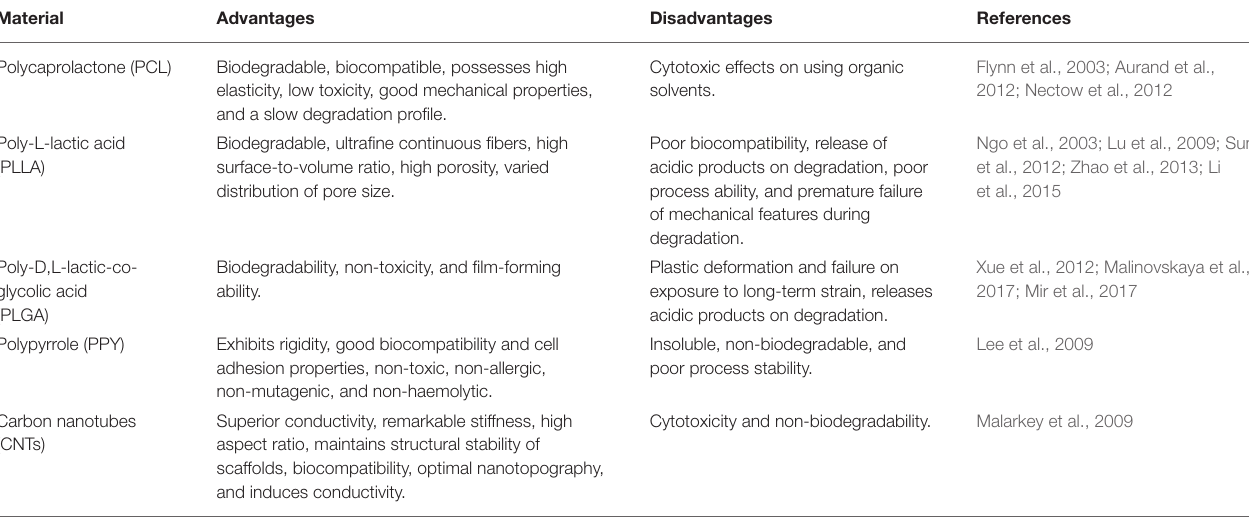
TABLE 2 | Advantages and disadvantages of synthetic biomaterials.